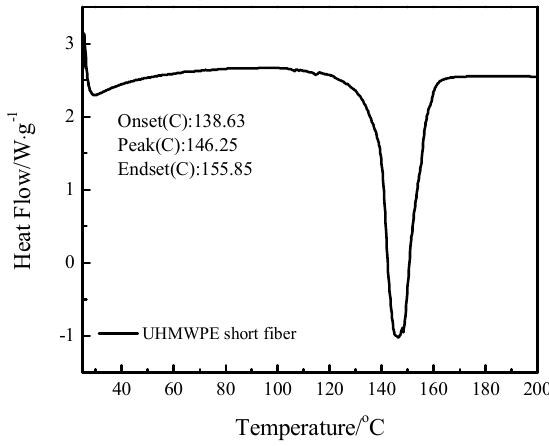
Figure 1. The DSC curves of the UHMWPE short fiber.